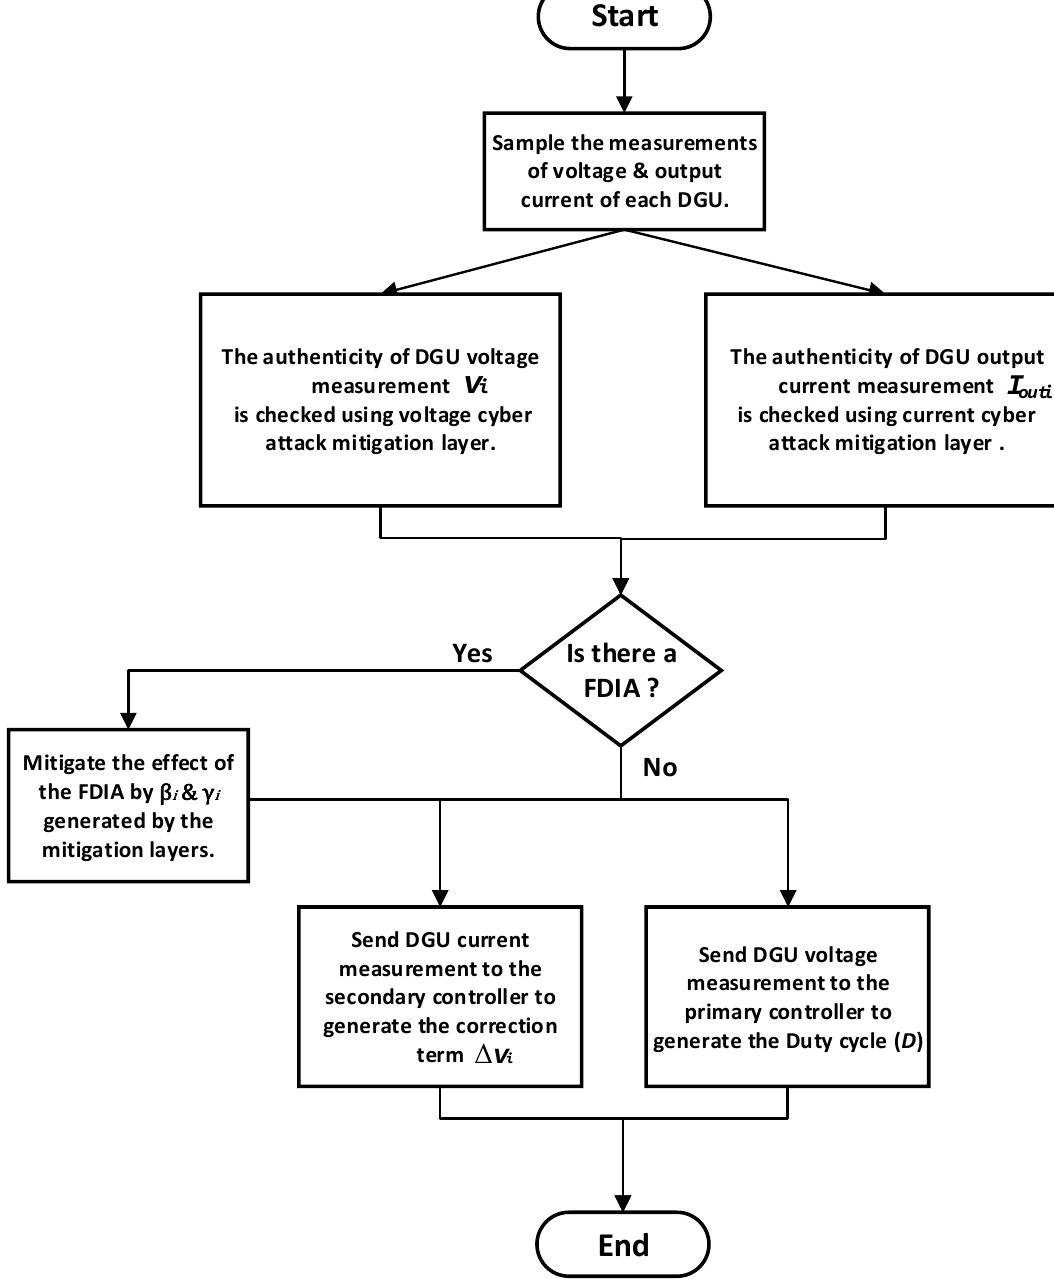
Figure 7. Flowchart for the overall control strategy with cyber-attack mitigation layers.